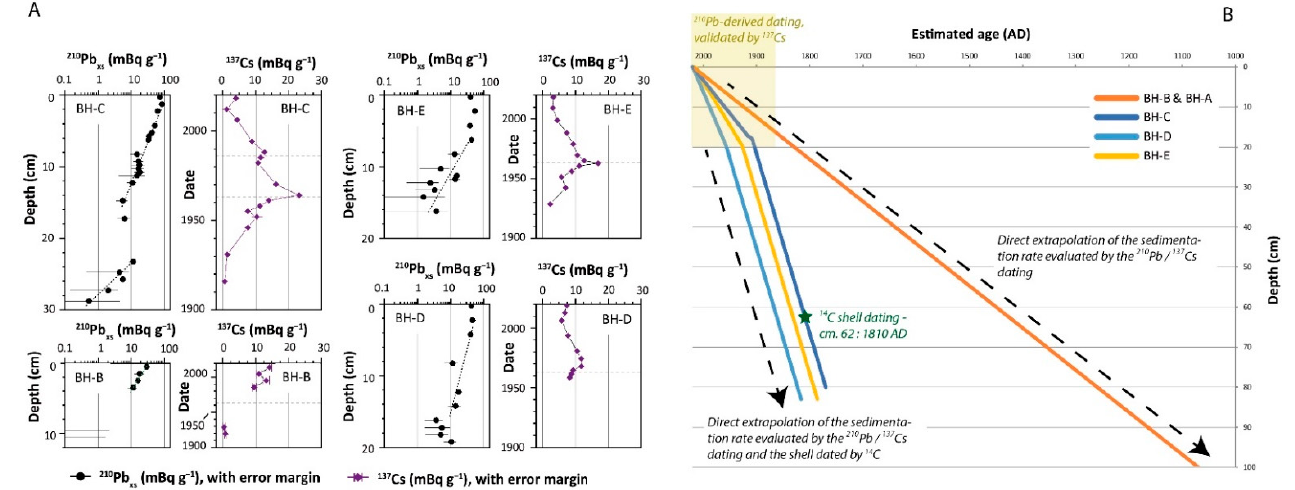
Figure 3. Detailed results of radioisotopic dating. ( A ) 210 Pb xs profiles with depth in cores BH-B, -C, -D, and -E. 137 Cs profiles with the 210 Pb xs -derived age model to test its validity. The lines highlight 1963 for all cores and also 1986 for the BH-C core. ( B ) Age models of cores estimated from the 210 Pb-derived (all cores) and 14 C shell (BH-C, -D, and -E) dating (Unit: mBq.g − 1 (Megabecquerel per